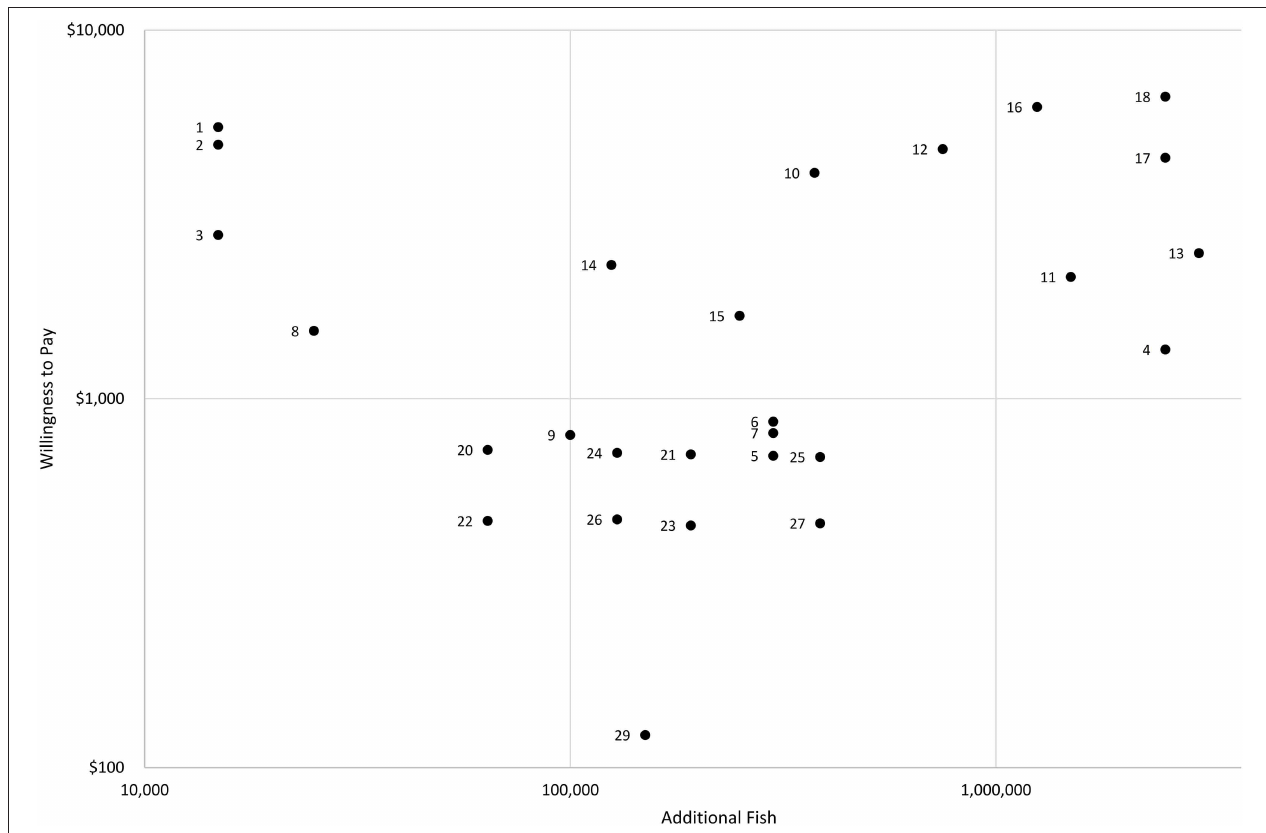
FIGURE 1 | Total economic value of Western US salmon increases vs. size of salmon increase (Net Present Value per household 2015$, r = 7